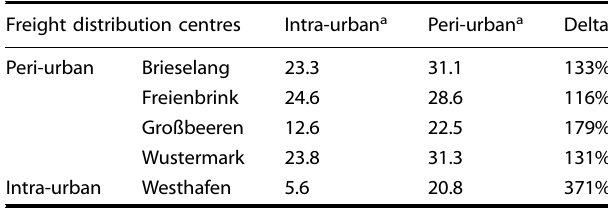
Table 6. Average distance from existing freight distribution centres to districts and municipalities (cf. Fig. 4) in the intra- and peri-urban space, with Delta indicating the relative increase in the